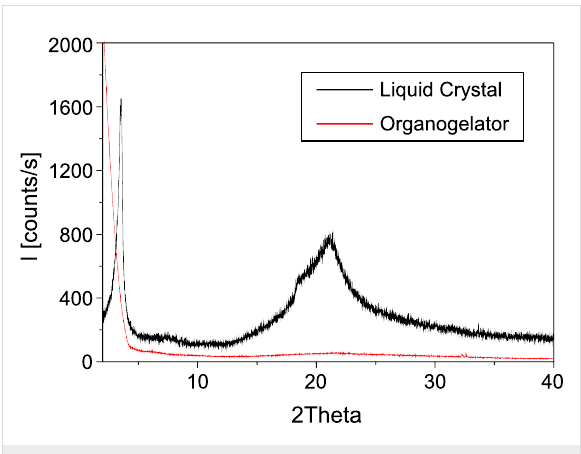
Figure 2: X-ray diffraction patterns of G3 as an organogelator and liquid crystal.